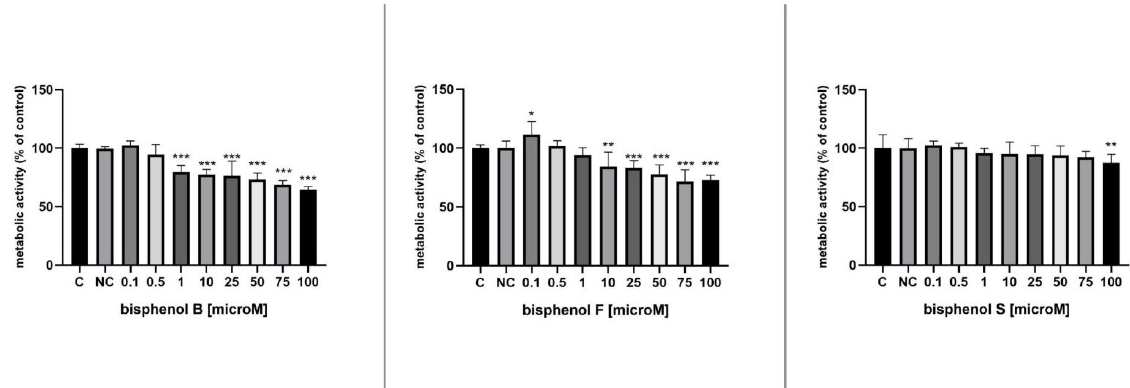
Figure 2. The impact of bisphenol B, F, and S on H295R cells metabolic activity in vitro. Abbreviations: C—control group, NC—negative control. The mean ( ± SEM) optical density percent of the control (untreated) and treated (bisphenol) groups is represented by each bar. The data were collected from three separate experiments. Between the control and experimental groups, the significance levels were established at *** ( p < 0.001), ** ( p < 0.01), and * ( p < 0.05).